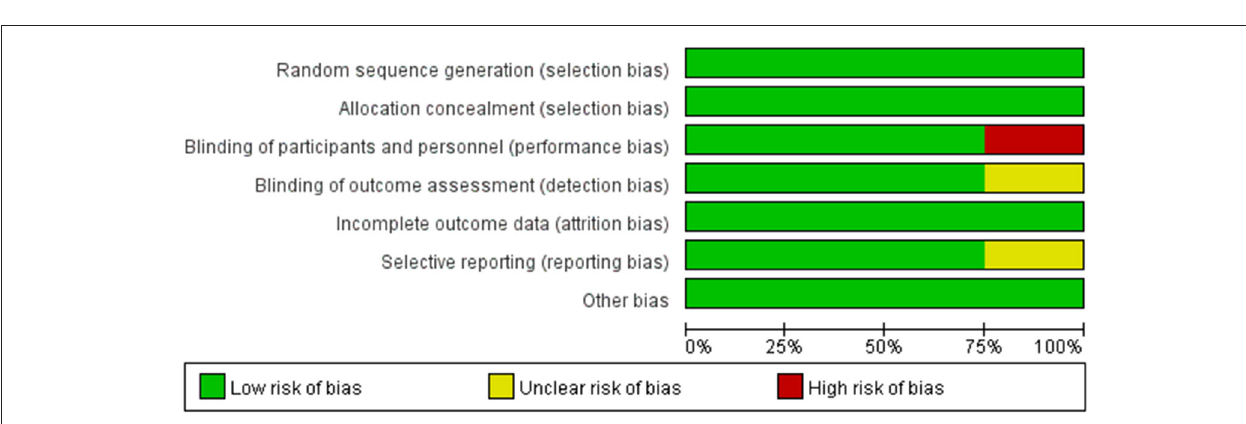
FIGURE 5 | Risk of bias of all included